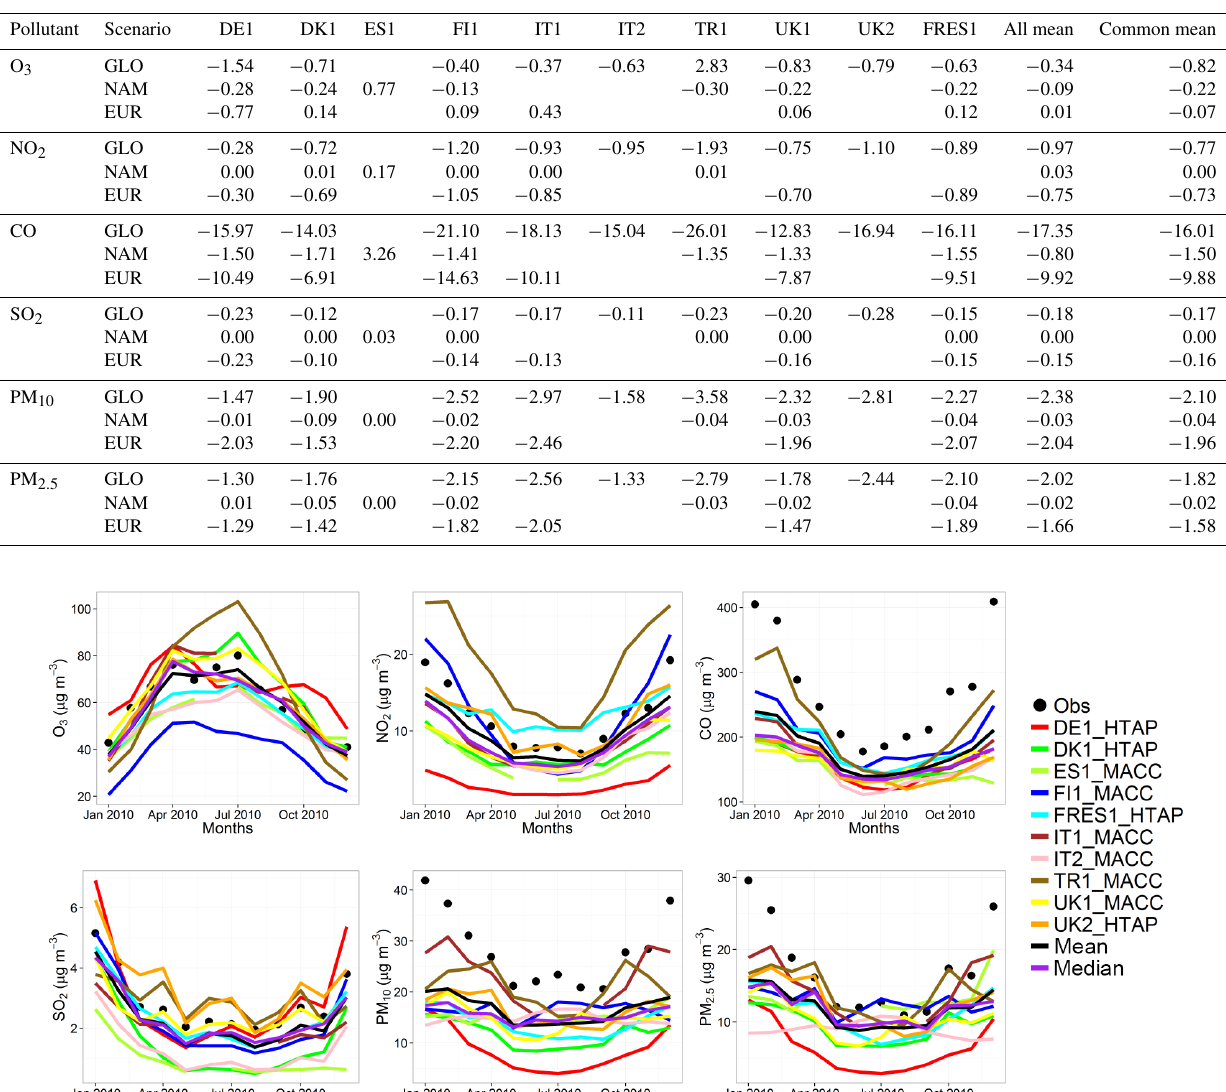
Table 4. Annual mean absolute differences (ppb for gases and µgm − 3 for particles) between the base case and the different emission perturbation scenarios as calculated by the different model groups over the European domain.